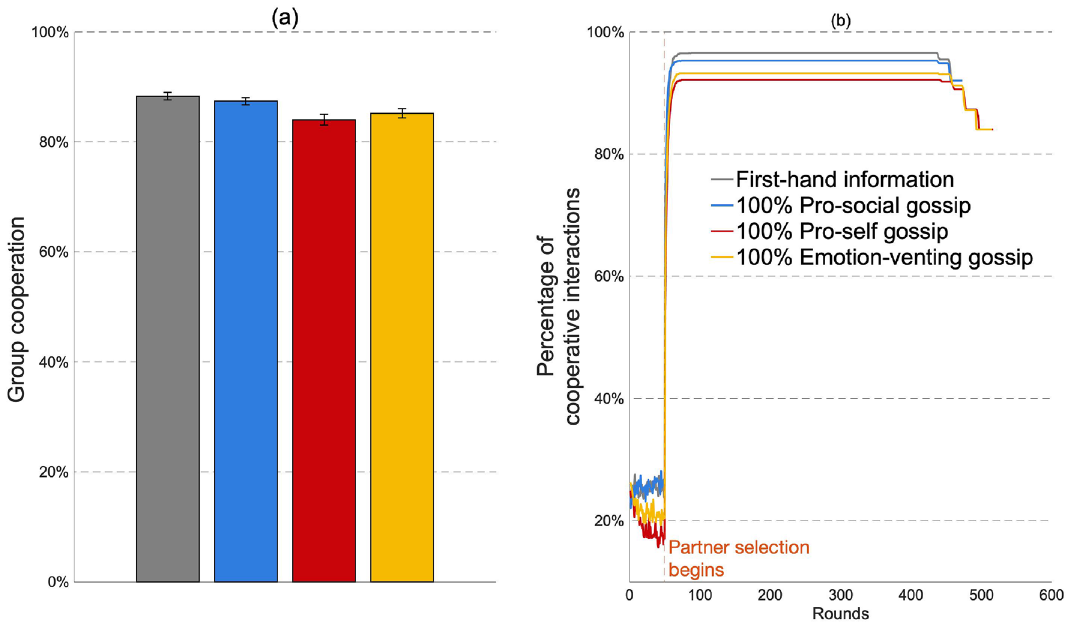
Figure 5. Results for conditionally cooperating agents when they selected their preferred partner. ( a ) Average group cooperation for first-hand information and gossip motives, ( b ) Percentage of cooperative interactions over rounds for first-hand information and gossip motives.